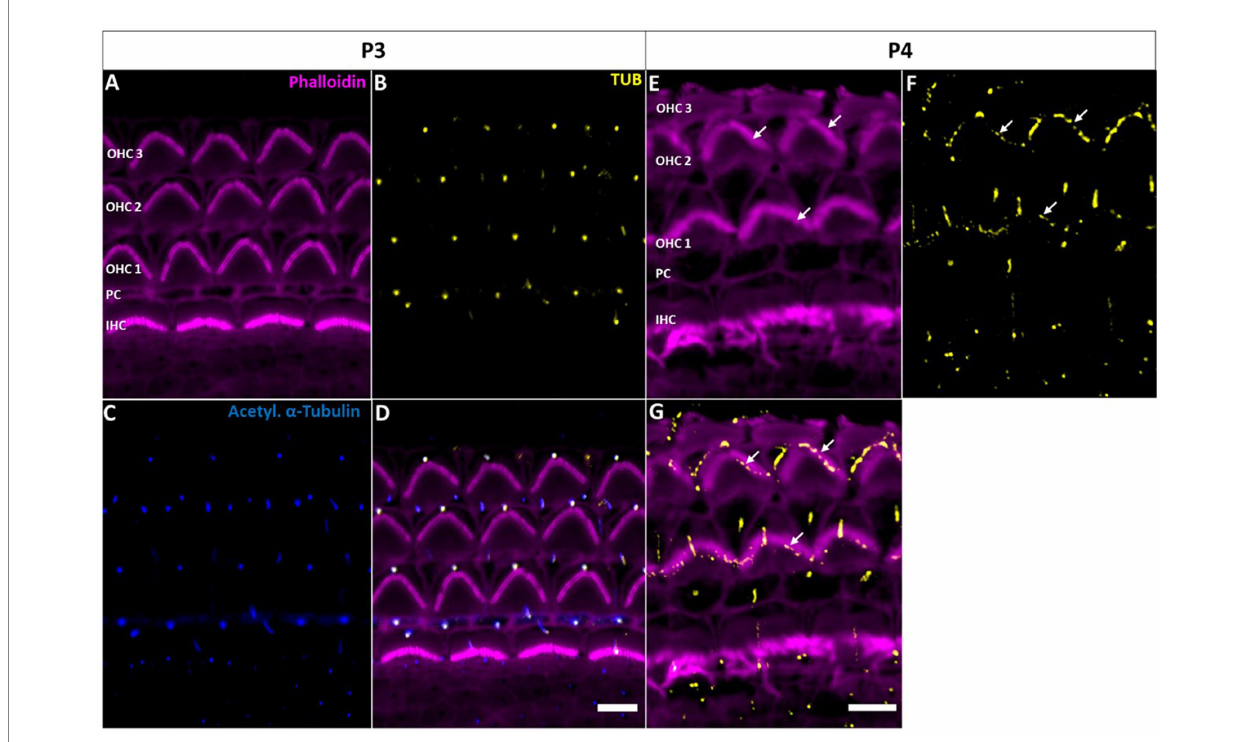
FIGURE 2 Tubby localization to hair cell kinocilia and supporting cell primary cilia in the early postnatal cochlea. (A − D) P3 whole-mount immunohistochemical staining of Tubby (yellow), Phalloidin (staining actin, magenta) and acetylated α -tubulin (blue) in the mouse organ of corti. Tubby is localized to the IHC and OHC kinocilia, while it is additionally localized to ad subset supporting cell primary cilia. (E − G) P4 whole-mount immunohistochemistry staining of Tubby (yellow) and Phalloidin (staining actin, magenta). Tubby is localized to hair cell kinocilia and a subset of supporting cell primary cilia (big arrows) but is additionally localized to the top of the tallest row of outer hair cells stereocilia (small arrows) Scale bar 5 μ